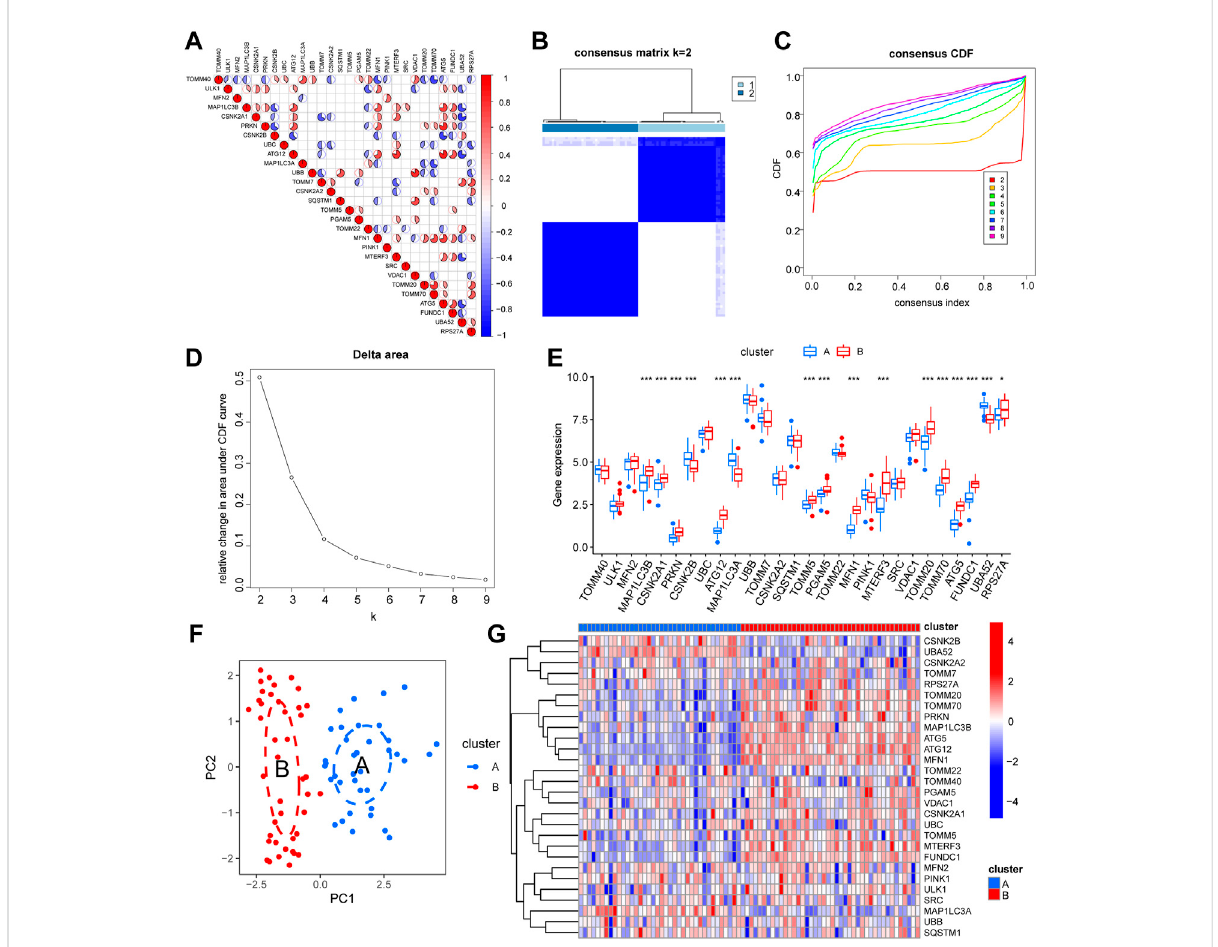
FIGURE 2 Expression characteristics and molecular grouping of mitophagy-related genes in uveal melanoma. (A) Correlation heat map display of mitophagy-related genes co-expression. (B – D) Consistent clustering (K = 2) results of TCGA-UM dataset based on mitophagy-related genes expression (B, cluster1: clusterA; cluster2: clusterB). CDF curves for different numbers of clusters in consistent clustering (C) and delta plot of area under the CDF curve (D) , dividing the samples into group A and group B. (E) Box plot of differential expression analysis of mitophagy-related genes in different isoforms of the TCGA-UM dataset, blue represents group A and red represents group B. (F) PCA analysis results of different subtypes of TCGA-UM dataset, blue represents group A, red represents group B. (G) Differential expression analysis of different isoforms of mitophagy-relatedgenesintheTCGA-UMdataset complexheat mapdisplay, bluerepresentsgroupA,redrepresentsgroupB. Ns,notsigni fi cant;*, p < 0.05; **, p < 0.01; ***, p < 0.001. TCGA, The cancer genome atlas; UM, uveal melanoma; CDF, cumulative distribution function; PCA, principal component analysis; KM, Kaplan –